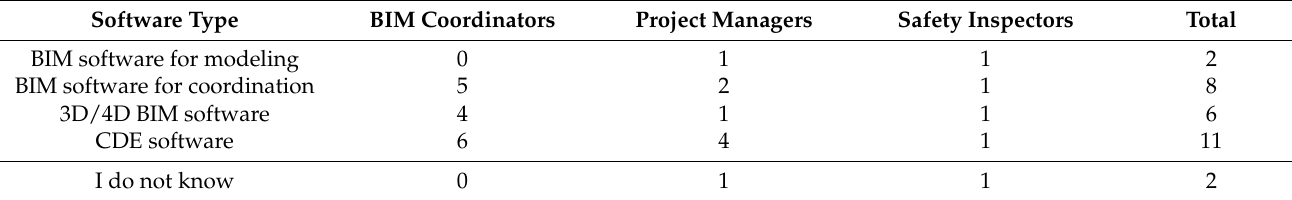
Table 6. Responses to the question: “What kind of BIM software would be the most appropriate/practical/efficient for automatic hazard detection?” 1